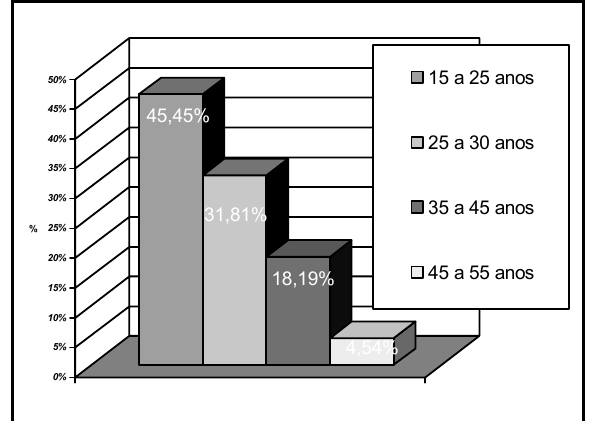
Figure 4 – Distribuição dos pacientes com anemia falciforme, por faixa